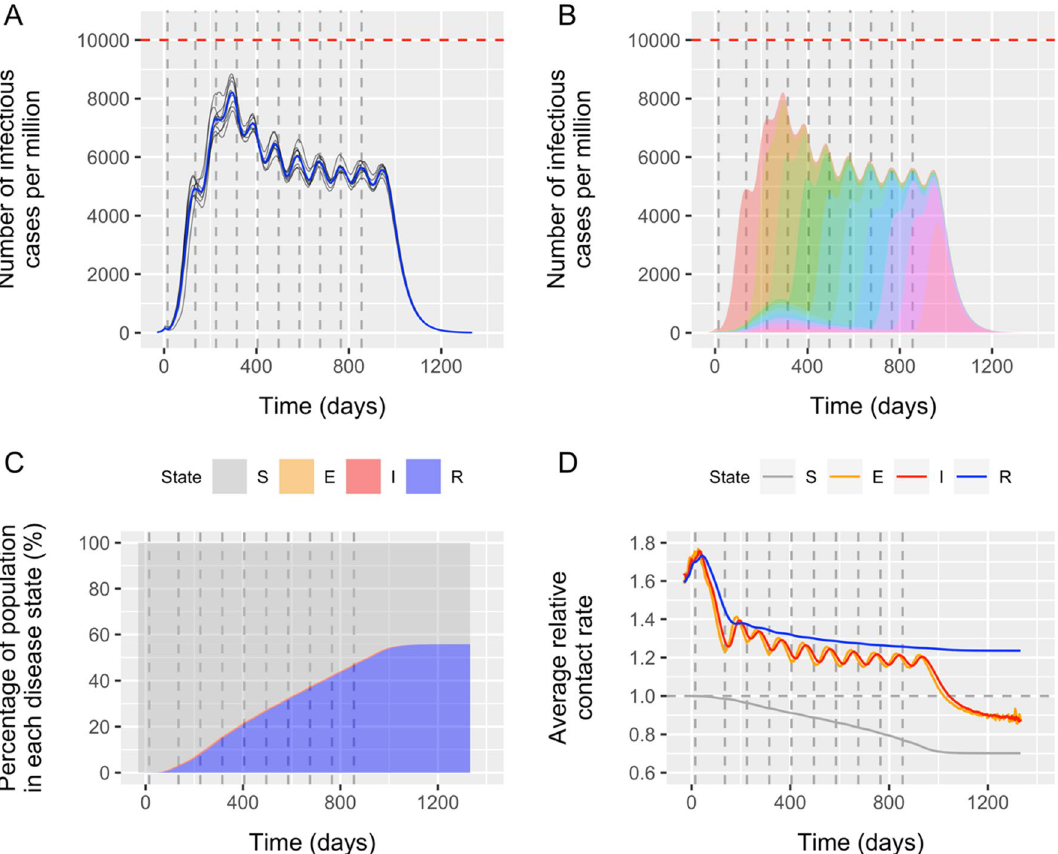
Figure 1. Model-predicted outcome of a phased lift of control against COVID-19 in a population of 17 million (the Netherlands). The population (a country or part of a country) is divided over 10 superclusters (provinces or municipal health services catchment areas), each harboring 1700 clusters (towns, wards or villages) with on average 1000 inhabitants. ( A ) Overall number of COVID-19 cases per 1 million for 8 model runs (average trend in blue). ( B ) Contribution of each of the 10 superclusters (colored areas) to the overall average number of cases. ( C ) Proportion of the population in the modelled disease states: susceptible (S), exposed (E), infectious/ symptomatic (I), and removed/immune (R). ( D ) Average relative contact rate of individuals in each disease state. Time is defined in terms of days since onset of intensive control in the entire population. The 10 vertical dashed lines indicate the timing of the moments of (permanently) lifting control in the successive superclusters. In the first supercluster, the one with the highest initial burden, lifting of control occurred after 15 days, a (random) second supercluster followed 120 days later, followed by a phased lifting of control in another supercluster each 90 days (random order). The horizontal red line in ( A ) and ( B ) indicates the threshold of 10 thousand COVID- 19 cases per million, which corresponds to the maximum IC capacity in the Netherlands